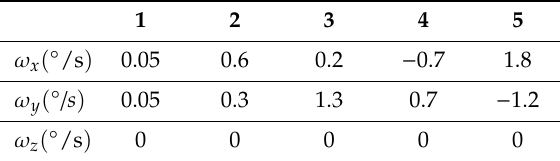
Table 3. Star images at different angular velocity.